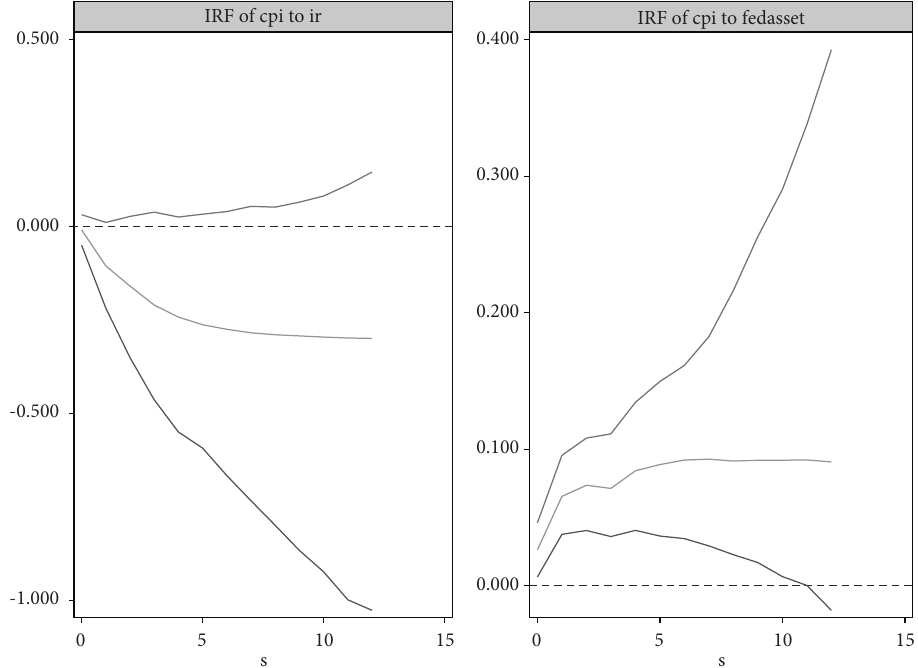
Figure 2: Impulse responses of CPI to U.S. monetary policy shock in BRICS countries.